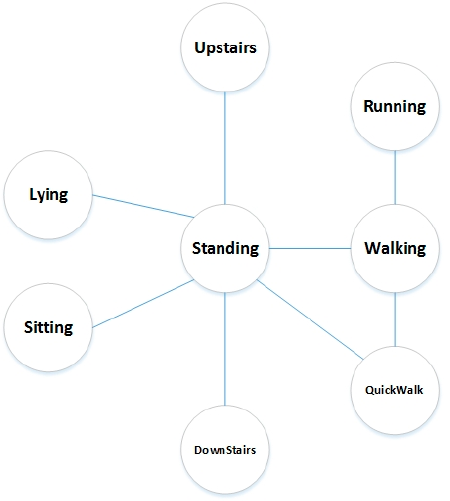
Figure 4. Activity transition diagram.